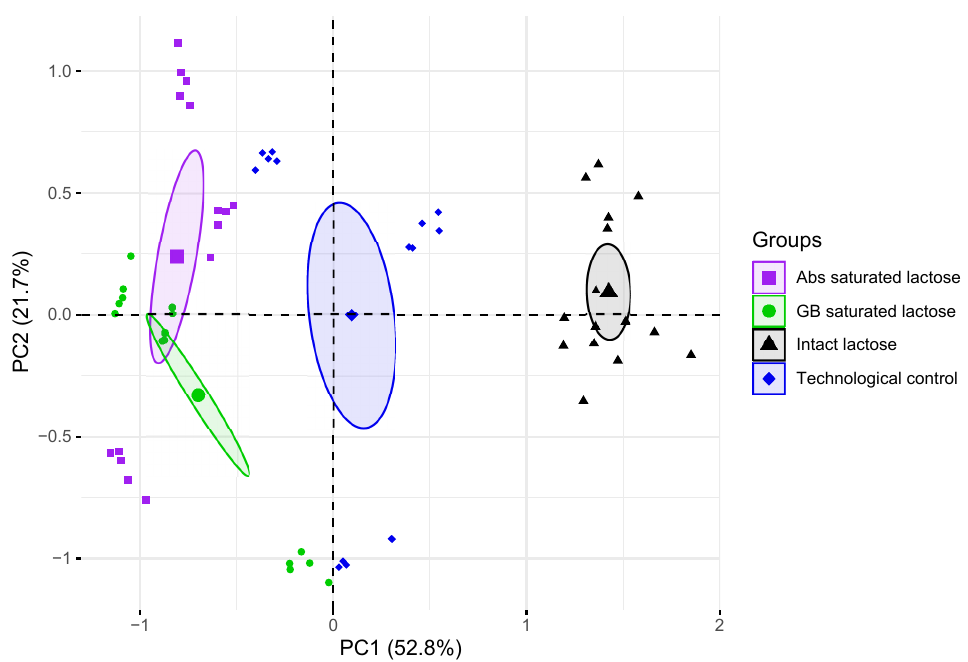
Figure 6. Projection of density-normalized absorption spectra of control tablets and lactose mono- hydrate saturated with dilutions of substances onto subspace of the first and second principal components (PC1, PC2). Enlarged points denote centroid (average coordinate) of corresponding group, ellipses outline the 95% confidence interval for centroid